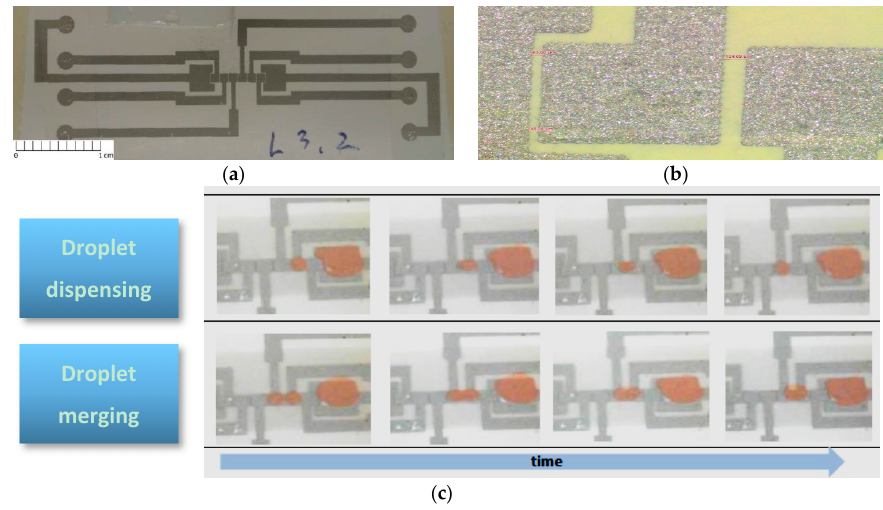
Figure 8. ( a ) DMF device screen-printed on paper substrate; ( b ) Zoom view of the printed electrodes; ( c ) Droplet movement on a paper-based DMF device. Adapted from original in reference [52].